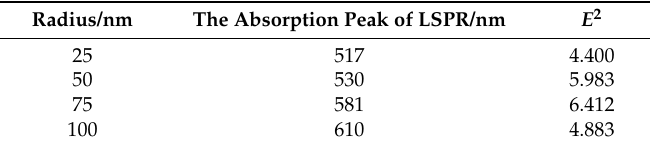
Figure 2. The extinction spectra of isolated Au nanospheres with different radii. Table 1. The electric near-field intensity of gold nanoshperes.